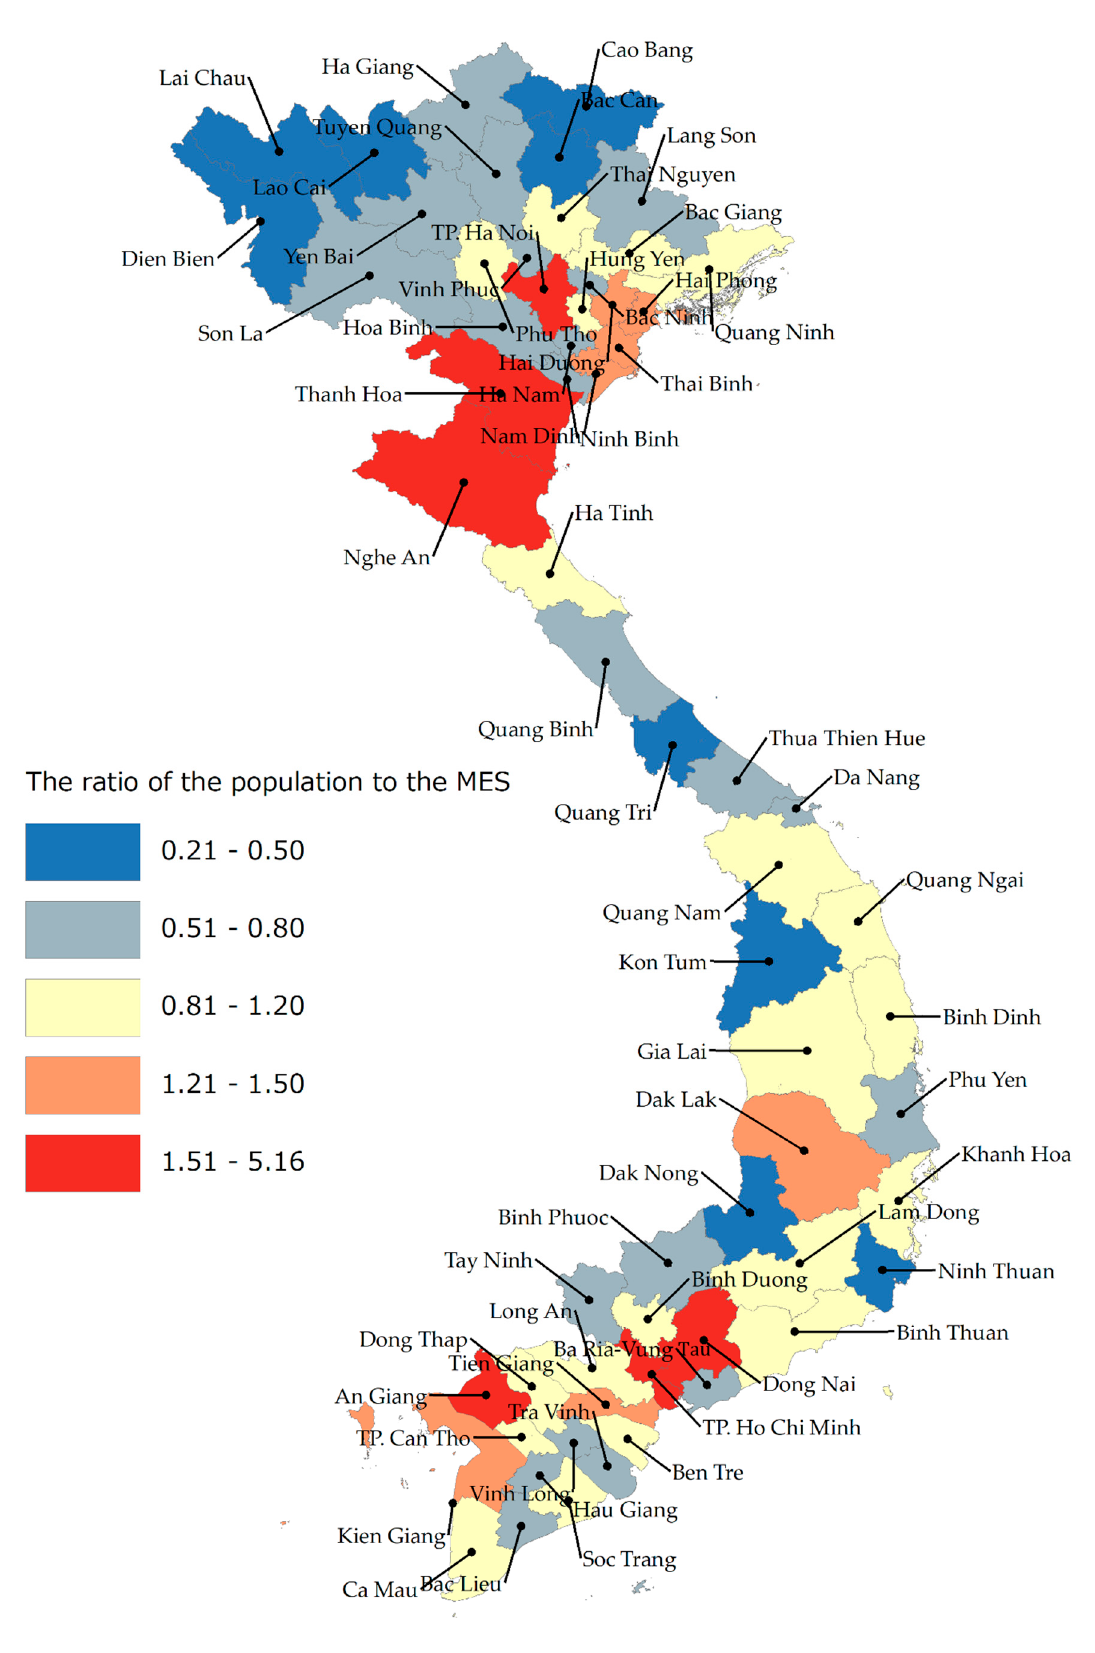
Figure 3. Map of minimum efficient scale (MES) in FY2009.